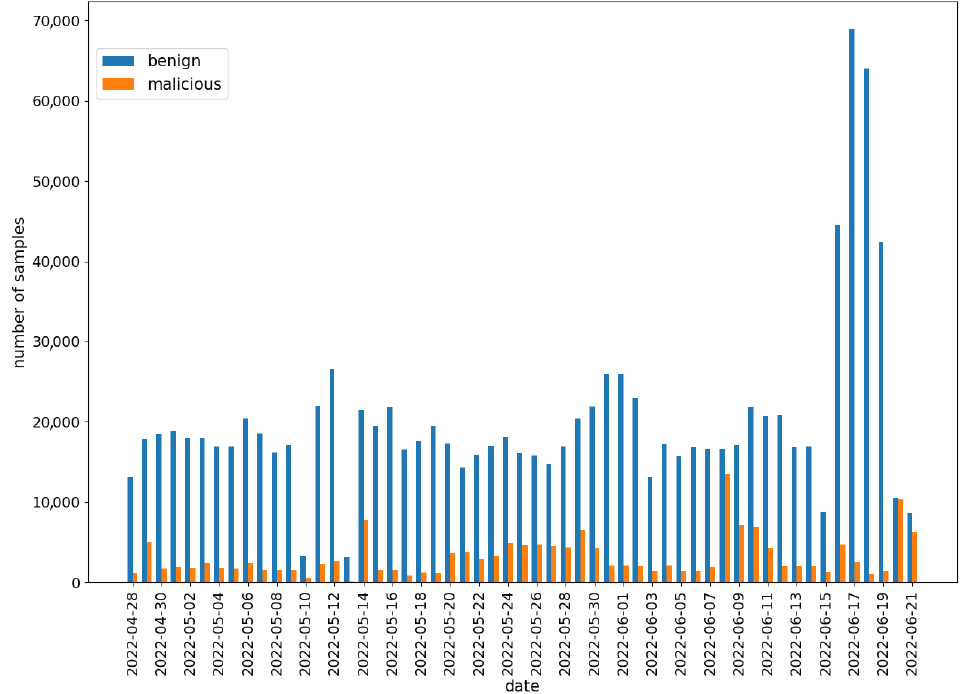
Figure 7. Labeled data distribution in Koodous from 28 April to 21 June.